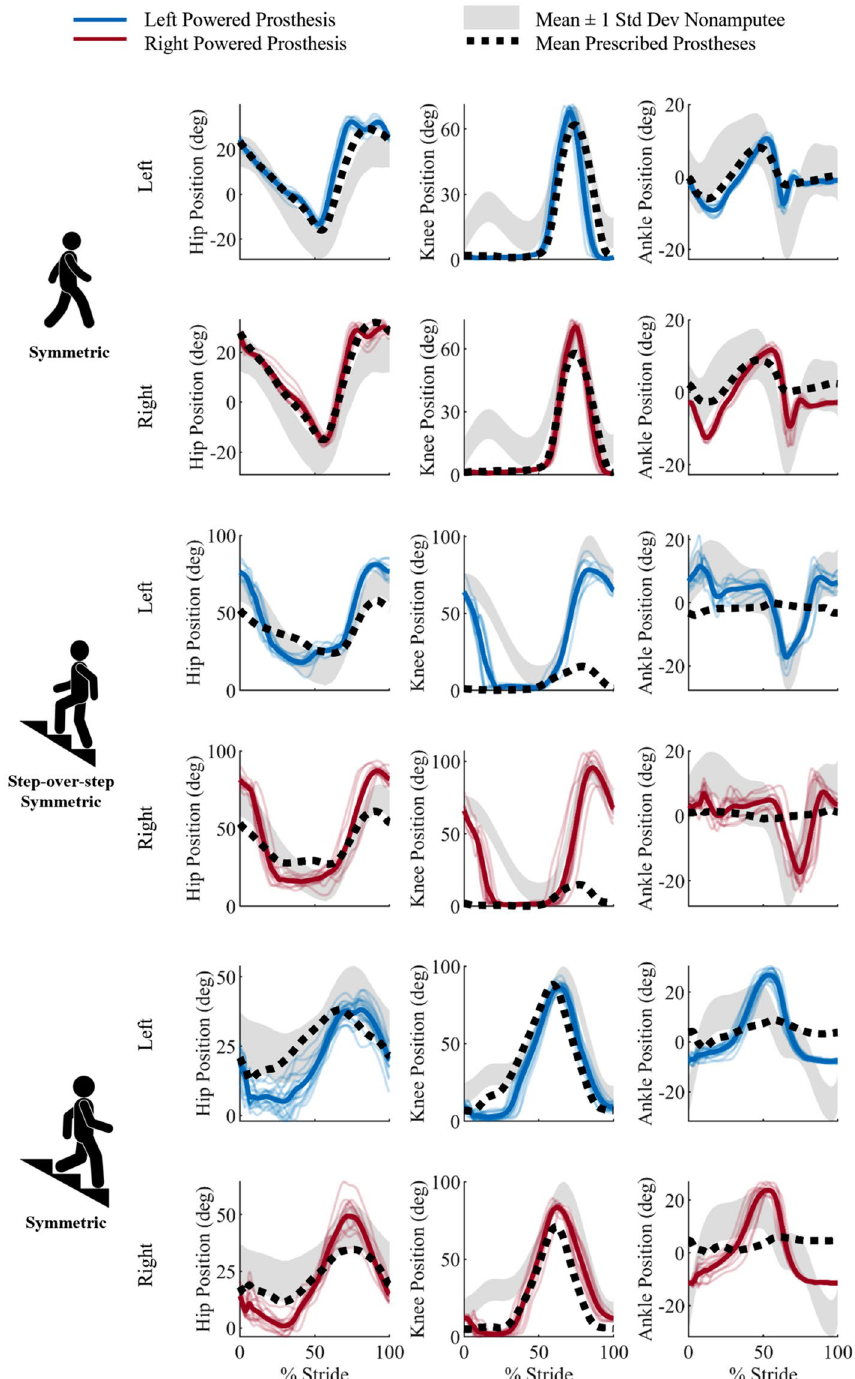
Figure 2. Kinematic profiles of the hip, knee and ankle joints during all ambulation activities. Specifically, the hip, knee, and ankle kinematics profiles (left to right) are shown for both the left side (top row) and right side (bottom row) for each ambulation activity. The ambulation activities are walking, stair ascent using the symmetrical step-over-step gait pattern, and stair descent (top to bottom). The solid blue lines represent the left side and the solid red lines represent the right side of the powered prostheses kinematic profiles with all strides represented by a bolded average line. The black dotted line is the average of the prescribed passive prostheses kinematics profiles. The shaded gray region is the standard deviation of the nonamputee reference data 26